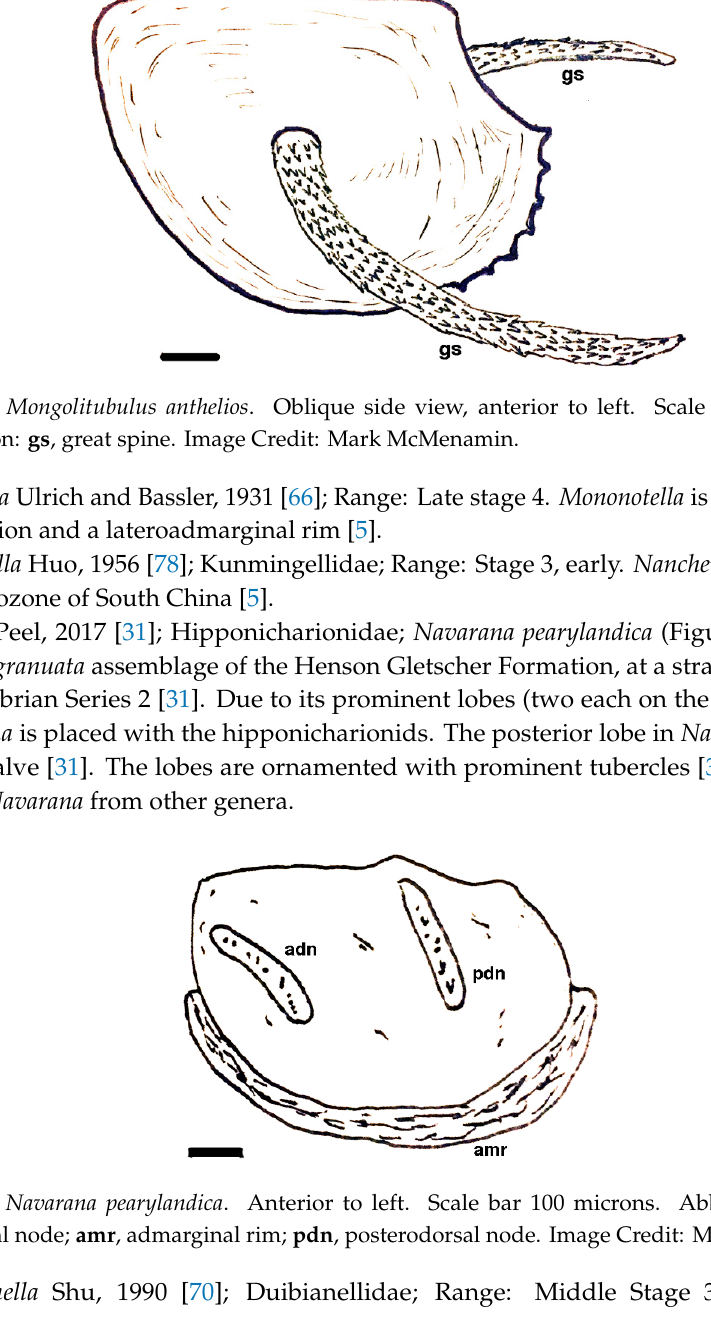
Figure 25. Neokunmingella moroensis . Anterior to left. Scale bar 200 microns. Abbreviations: a, anterodorsal cardinal marginal concavity; adn , anterodorsal node; cr , connecting ridge; pdn , posterodorsal node. Image Credit: Mark McMenamin. Nicolarites Vasilieva, 1994 [99]; Duibianellidae; This genus, known from fragmentary remains of Yakutia ( Nicolarites spasskyi ) and possibly North Greenland [6], consists of hollow tubes, often paired with nodes, that may be the remains of (possibly toxic) bradoriid spines as in Spinospitella . Oepikaluta Jones & McKenzie, 1980 [23]; Comptalutidae; Range: late Drumian. Jones and McKenzie [23] considered Oepikaluta to be a phosphatocopid, but the genus is considered here to be a bradoriid. Onagrocharion Topper et al. 2007 [100]; Hipponicharionidae; Range: Late Stage 3. The type species of the genus is Onagrocharion tuberosus. Ornamented tube form A; This form from the lower Cambrian of Australia [6] may represent a bradoriid spine. Second-order spines are present. Ovaluta Zhang, 1987 [101]; Bradoriidae; Ovaluta has a non-lobate shield [19].